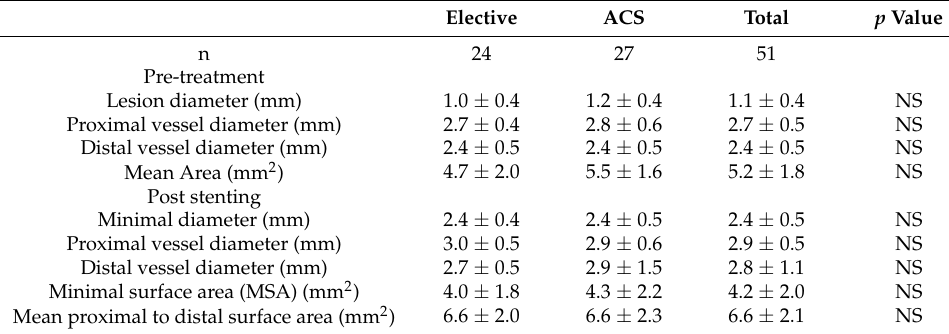
Table 4. Quantitative coronary